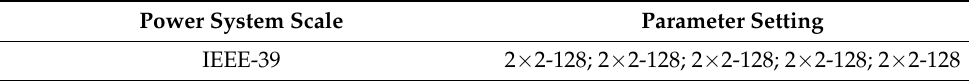
Table 2. Deep ConvLSTM model parameters for IEEE-39 bus power